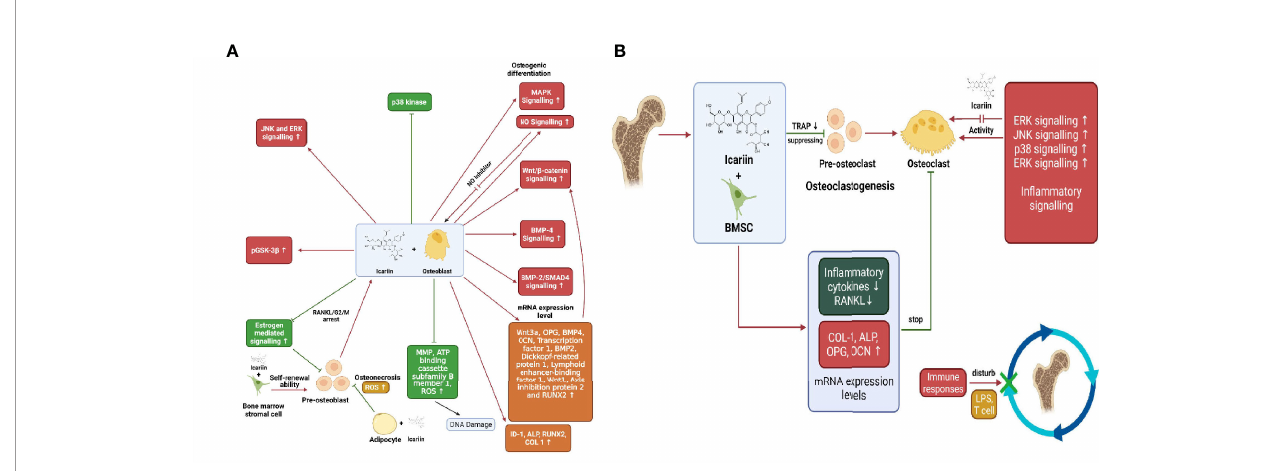
FIGURE 3 | (A) Osteogenic effects exerted by icariin through promotion of osteoblastogenesis and inhibition of adipocyte differentiation from pre-osteoblasts. (B) Inhibition of bone resorption by icariin via inhibition of osteoclast-related genes and